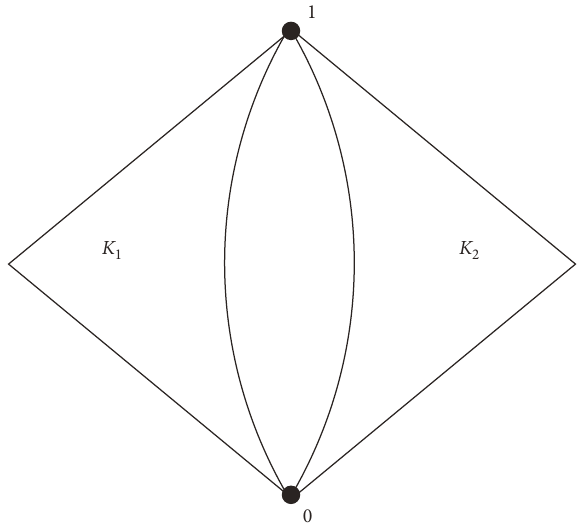
Figure 3: Union effect algebra K